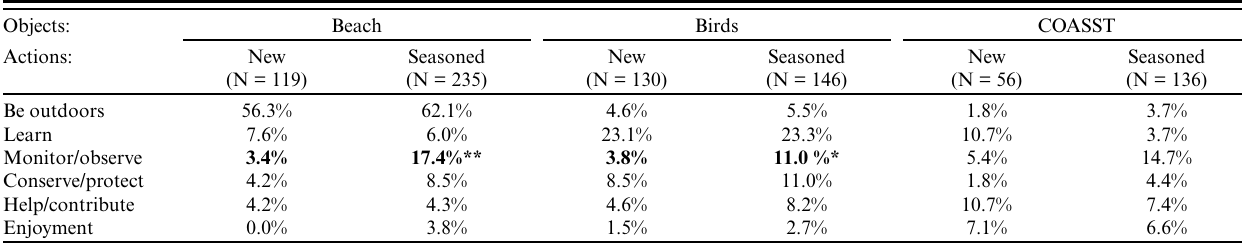
Table 2 . Co-occurrence of object*action codes, limited to the three most prevalent object codes: beach, birds, and COASST (see Fig. 2). Data are percent of respondents mentioning the relevant object (columns) and the corresponding action (rows) organized from larger to smaller percentages. Results are shown only for co-occurrences above a 3% response minimum for any single co-occurrence. Sample sizes are respondent counts. Statistically significant comparisons (new vs. seasoned; chi-square contingency tables) are bolded for clarity. Asterisks indicate the level of significance: *p < 0.05; **p < 0.01. COASST, Coastal Observation and Seabird Survey Team.